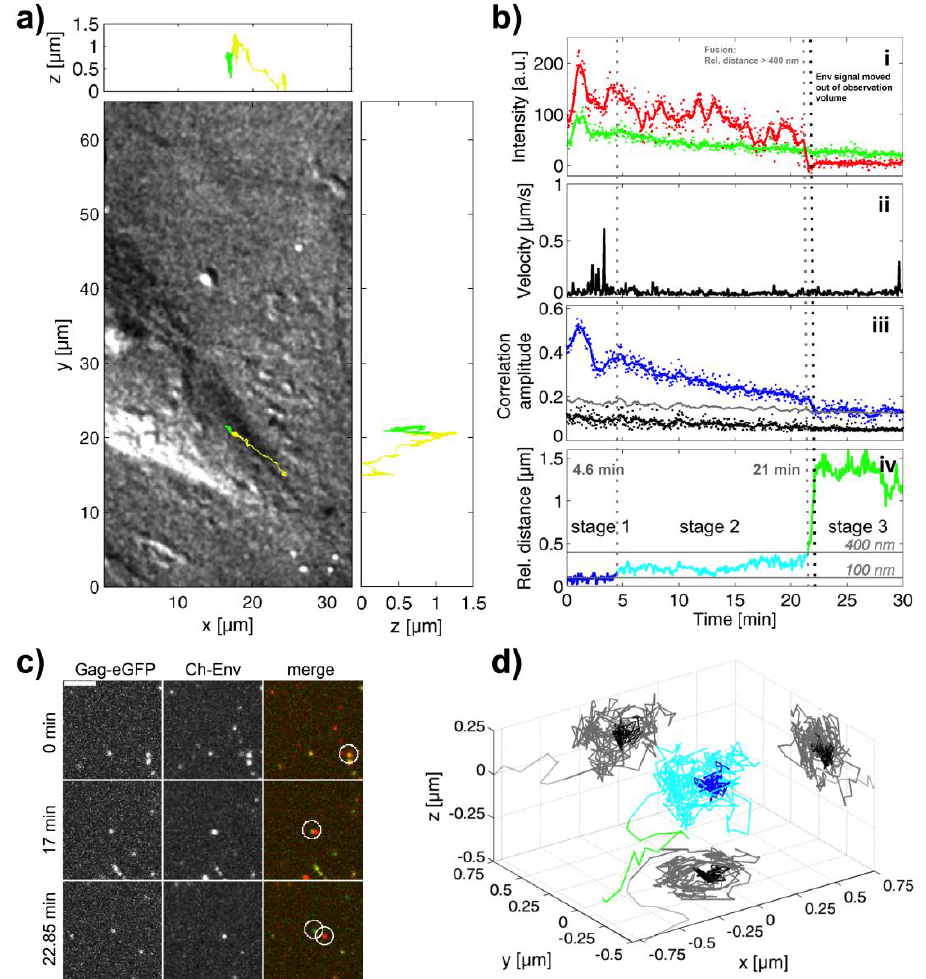
Figure 3. SFVmac Env-mediated fusion from the endosome. ( a ) A DIC image of a cell where the trajectory of the tracked SFVmac has been overlaid. The proportion of the track where the particle is double-labeled is plotted in yellow and motion of the capsid after color separation is plotted in green. x-z and y-z projects of the trajectory as shown in the upper and right panels respectively. ( b ) Results of the TrIC analysis along the trajectory are shown: ( i ) The background-corrected fluorescence intensity of the Gag-eGFP channel (green) and the mCherry-Env channel (red) are plotted as a function of time. ( ii ) The instantaneous velocity of the Gag-eGFP signal is plotted as a function of time. ( iii ) The amplitude of the cross-correlation of the TrIC analysis for the data (blue), the randomized control (grey) and threshold are plotted as a function of time. ( iv ) The relative distance between the eGFP-capsid and mCherry-Env signal is plotted over time. The distance of the Gag-eGFP to the mCherry-Env is plotted over time, with distances < 100 nm marked in blue (stage 1), between 100 and 400 nm marked in cyan (stage 2), and > 400 nm marked in green (stage 3). Solid lines were generated using running average of ~30 s. ( c ) A close up of three frames from the movie showing the tracked virus (circled in white) at di ff erent stages of the fusion process: bound to the plasma membrane (0 min), just after the virus has been internalized (17 min), and after the fusion is completed (22.85 min). Left: eGFP channel; Middle: mCherry channel; Right: merged image. Scale bar: 4 µ m. ( d ) A 3D-representation of the relative position of the mCherry-Env signal with respect to the Gag-eGFP signal distance color-coded according to the three stages shown in panel (biv). The circular movement of the envelope signal around the capsid in stage 2 (cyan) is clearly